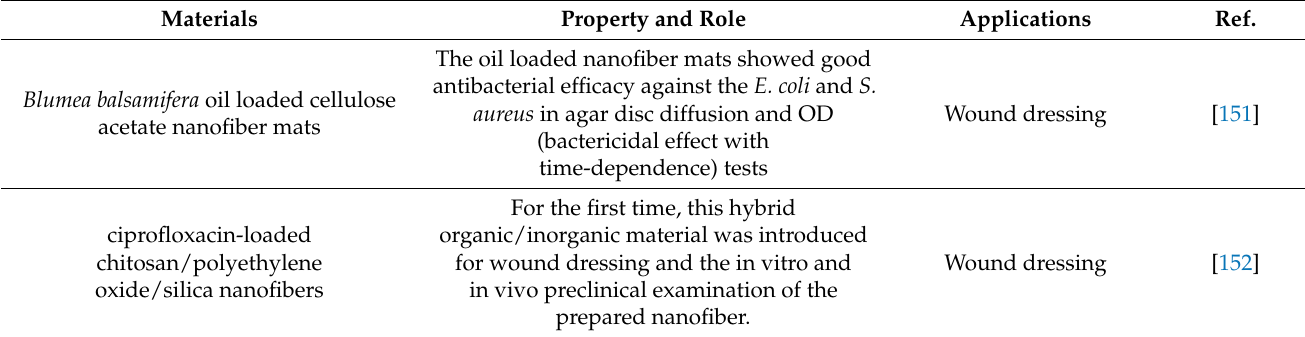
Table 4. Role of nanofiber materials in various wound-dressing